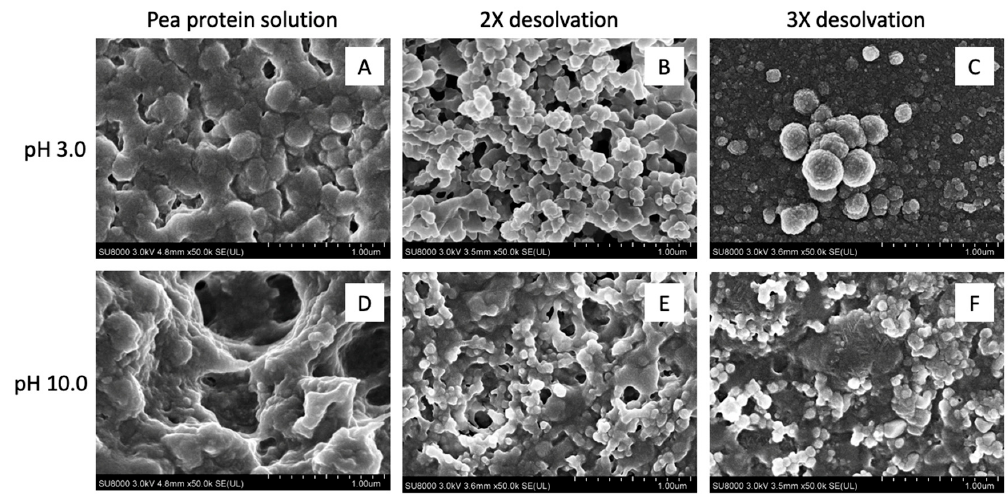
Figure 3. Microstructures of pea protein solutions ( A , D ) and 2 × ( B , E ) and 3 × ( C , F ) ethanol-desolvated nanoparticles at pH 3 ( A – C ) and pH 10 ( D – F ) obtained using a scanning electron microscope under 50,000 × magnification. The protein particles were prepared at 25 ◦ C and homogenized at 5000 psi for 5 min before air drying on the glass slide.